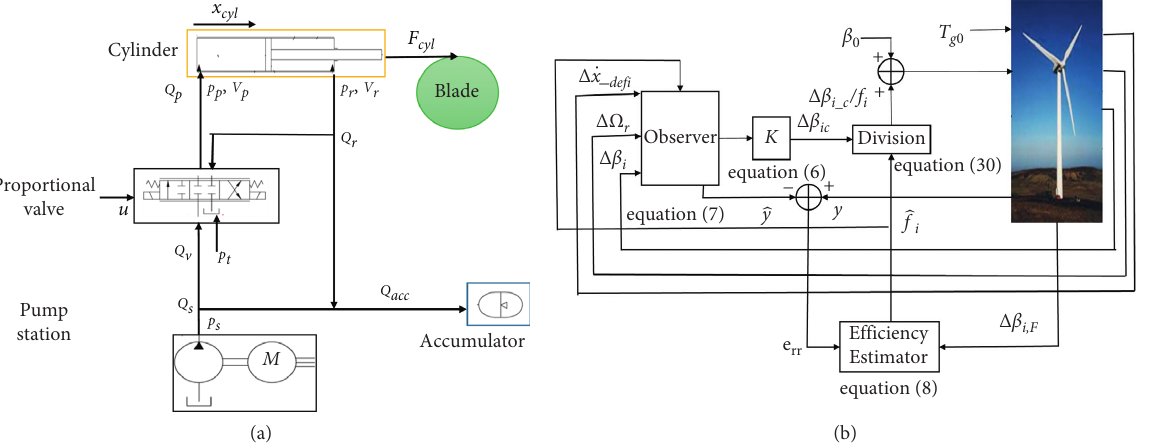
Figure 13: (a) The pitch actuator model. (b) The wind turbine control objective